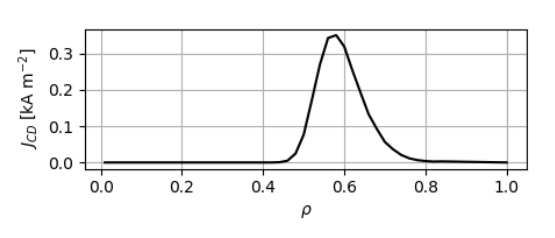
Figure 2. Driven current density profile giving maximum current drive at ρ = 0.55 for SPR-046. Current is driven for approximately ρ = 0.1 each side of the